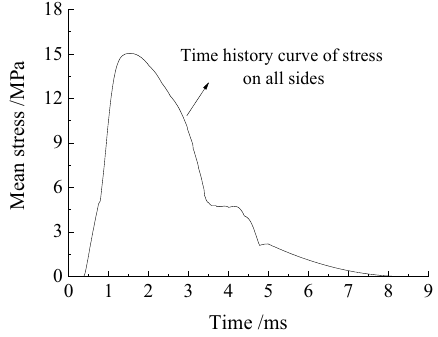
Figure 7. Mean stress on four sidewalls over time.